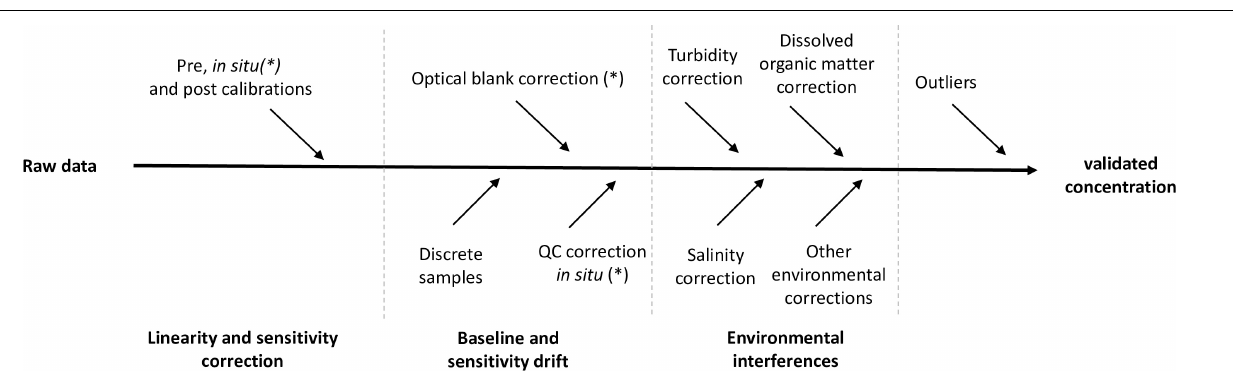
FIGURE 4 | Schematic view of the transformation of raw data across the various correction steps toward final nutrient concentration; some corrections might be applicable only in the case of wet chemical analyzers ( ∗